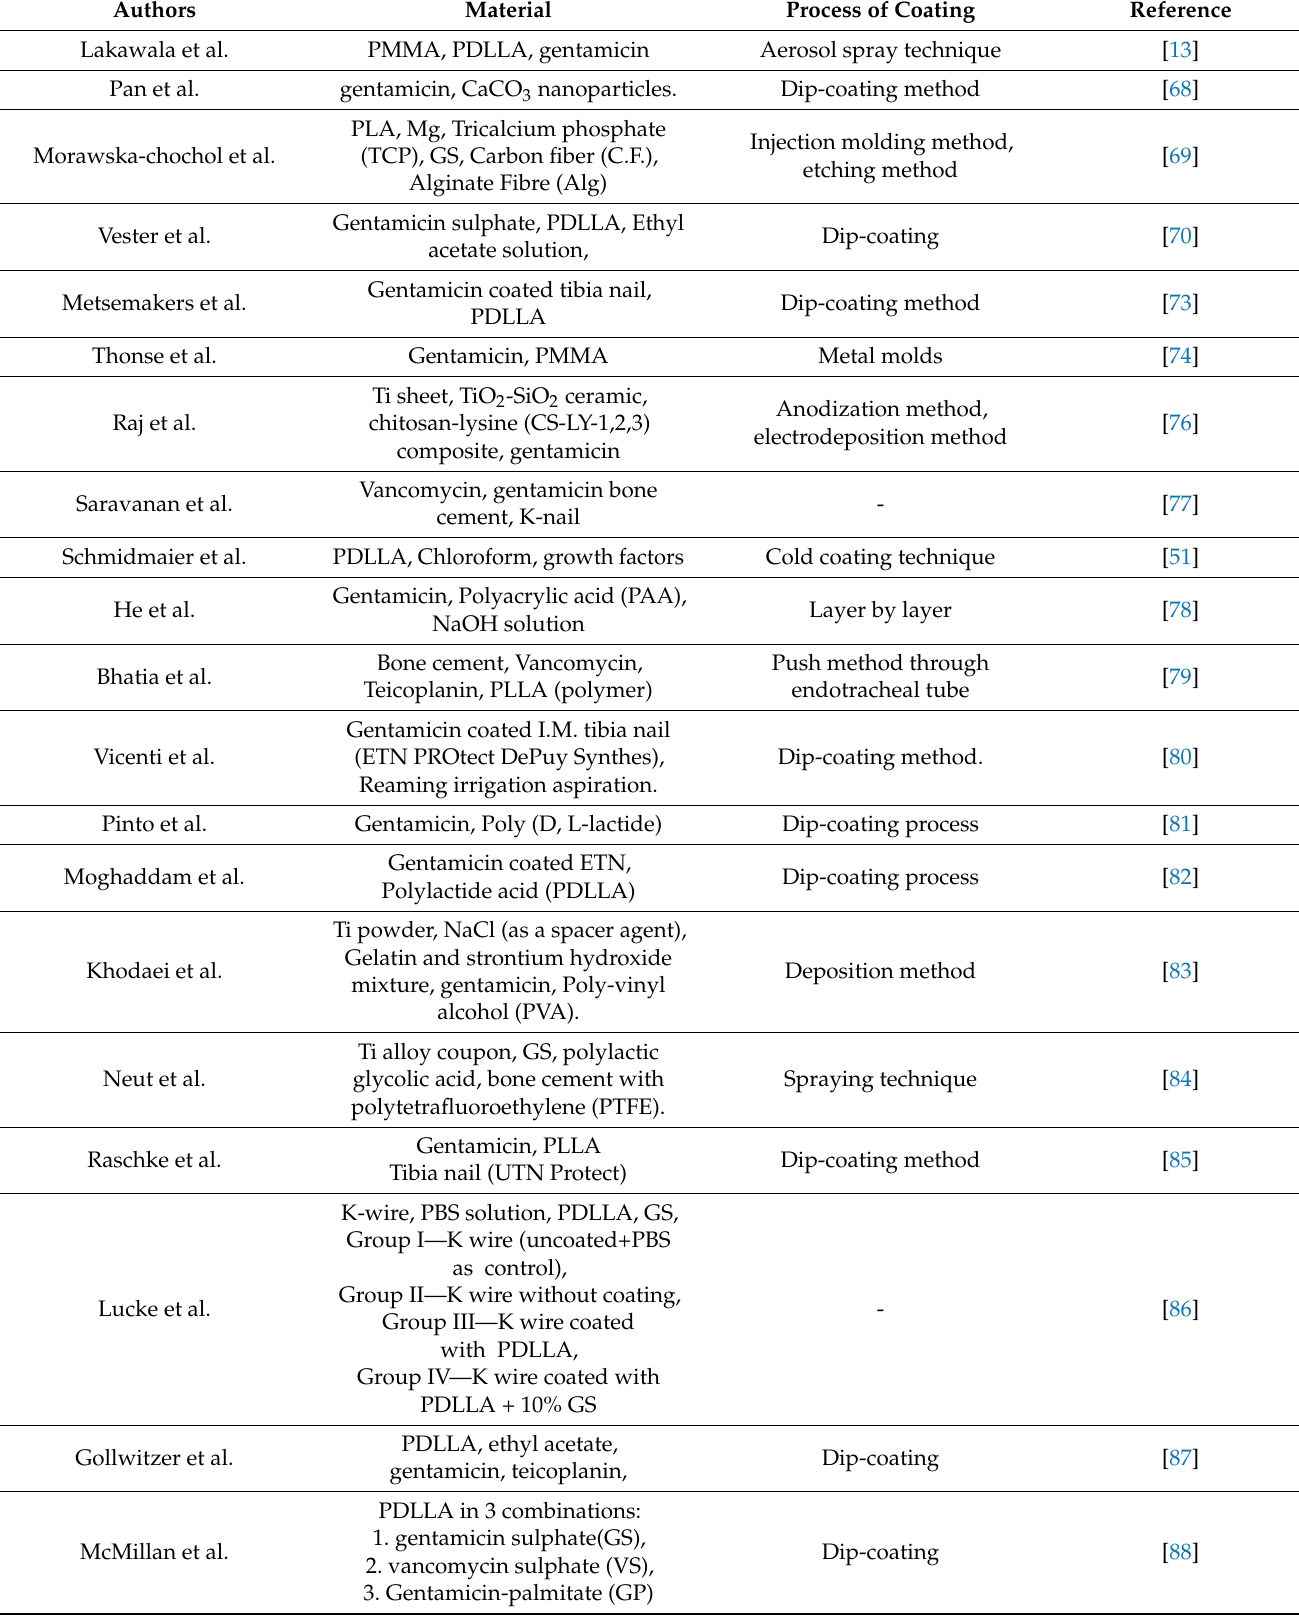
Table 2. Summary of clinical